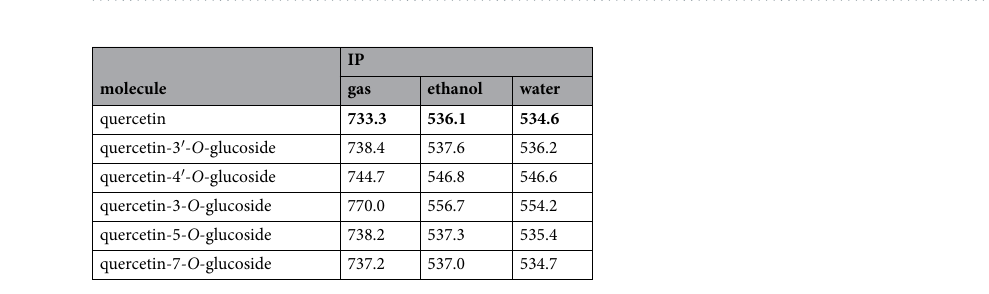
Table 3. Ionization potentials (IP) in kJ/mol obtained at M062X/6–311 + G ** level of